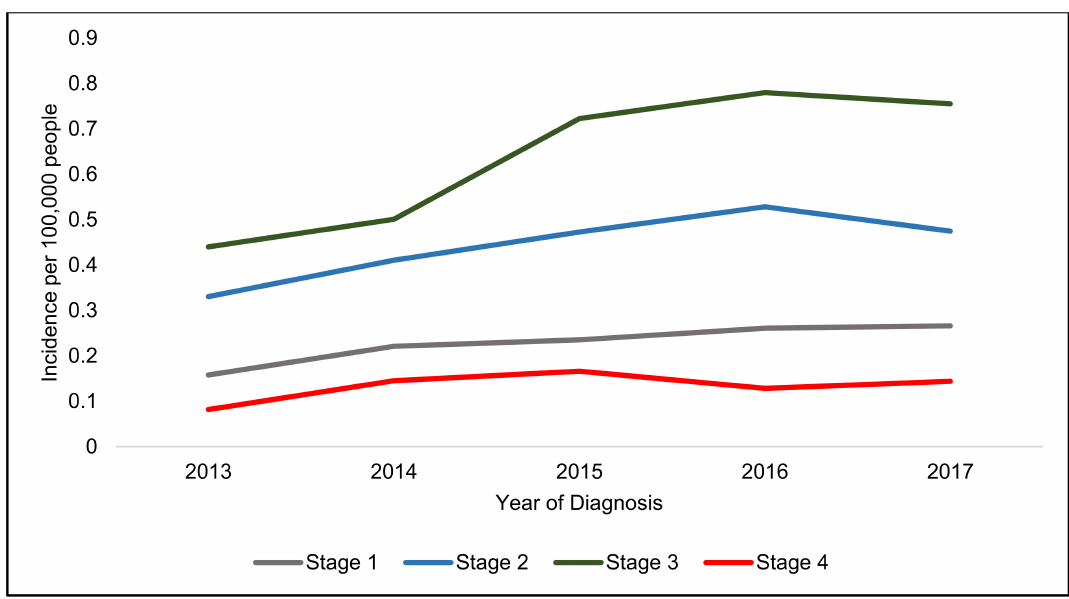
Figure 2. Incidence per 100,000 people in England from 2013–2017 in men and women stratified by